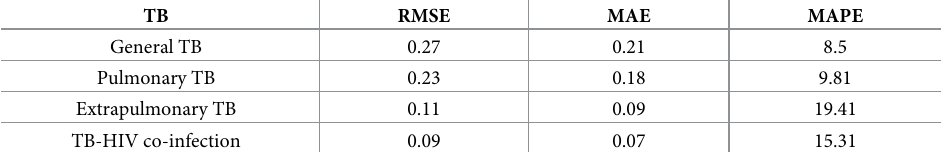
Table 3. Predictive analysis of the TB incidence according the clinical condition of the cases, Ribeir ã o Preto, S ã o Paulo, Brazil (2006–2017).